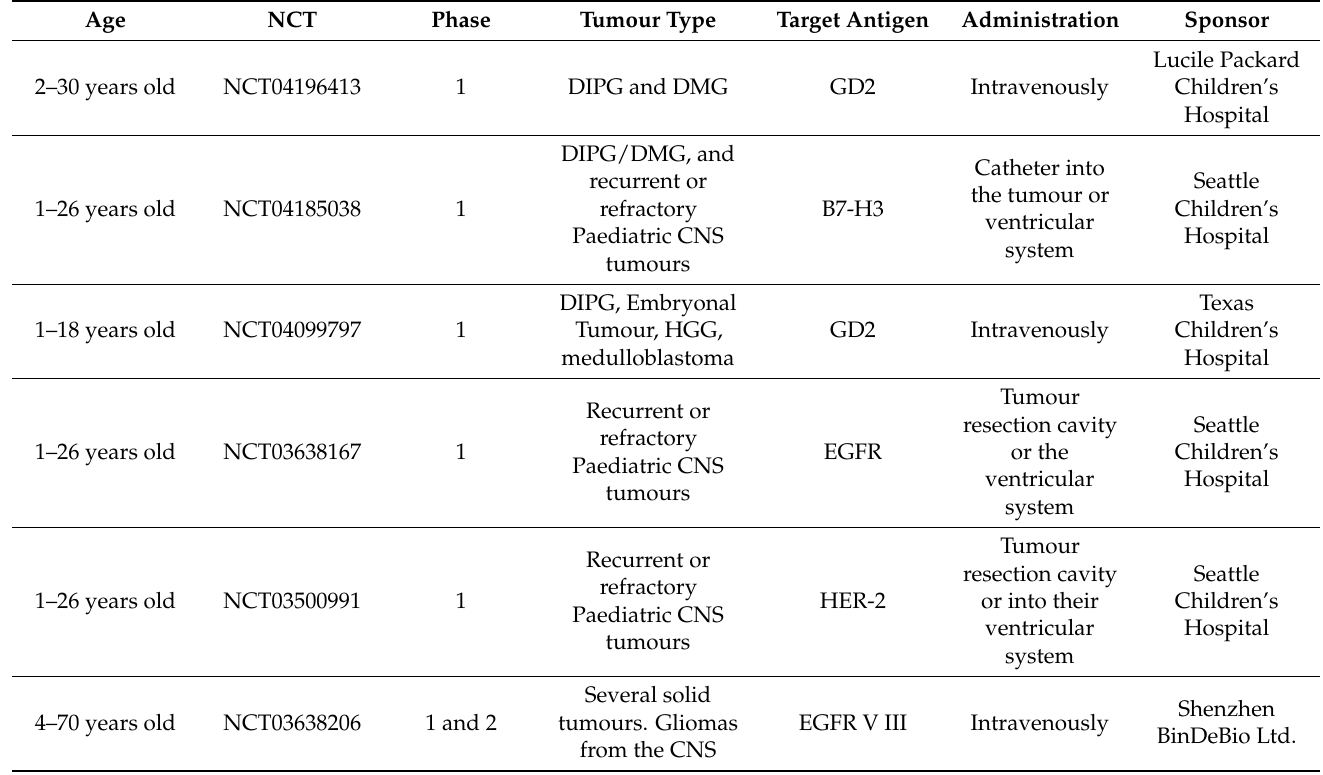
Table 1. Recruiting or active clinical trials using CAR T cells in children with CNS